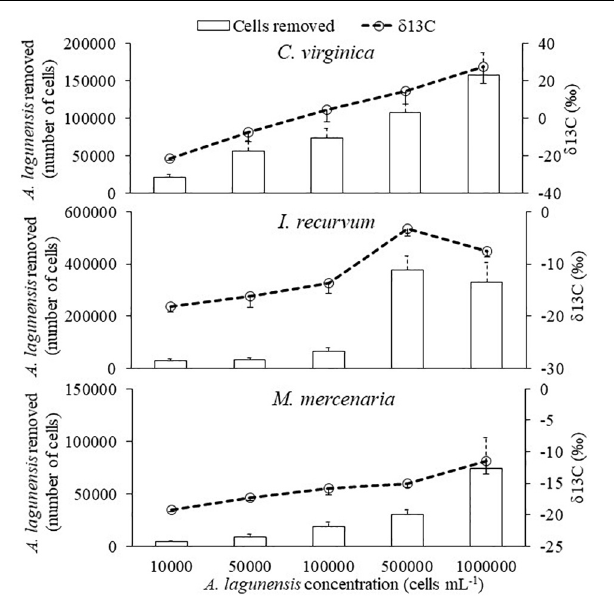
FIGURE 4 | The relationship between the number of Aureoumbra lagunensis cells removed (+SE) by bivalves (bars) and δ 13 C isotope values (SE) (line) at each algal concentration in one